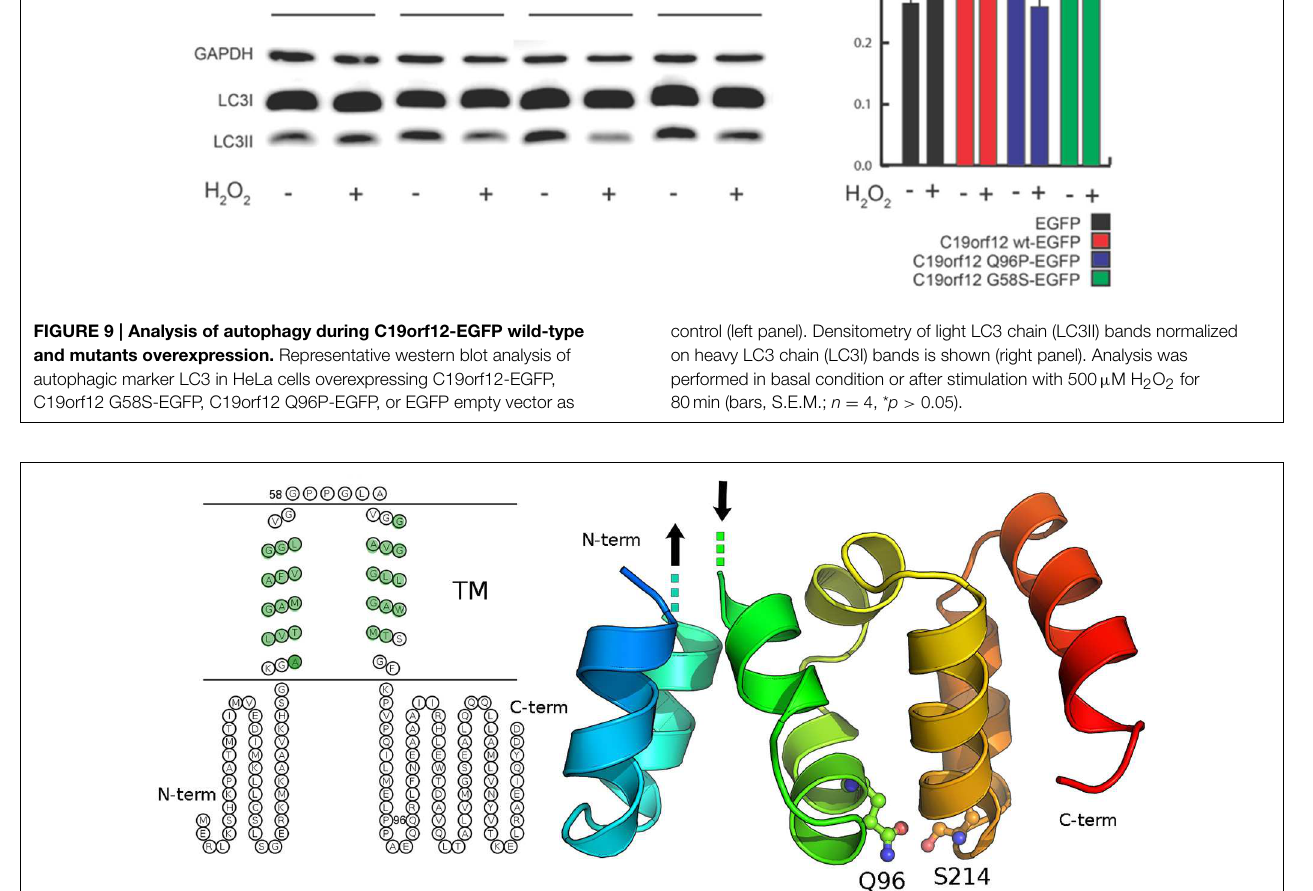
mutation site Gln96 and the residues Ser214 are shown as sticks and spheres. The protein is shown with shade of colors from blue to red, from the N- to the C-terminal extremity, respectively. The dots and the arrows illustrate the regions that are expected to connect the domain to the membrane. Gly58 is not reported since a reliable 3D model is not available for the transmembrane